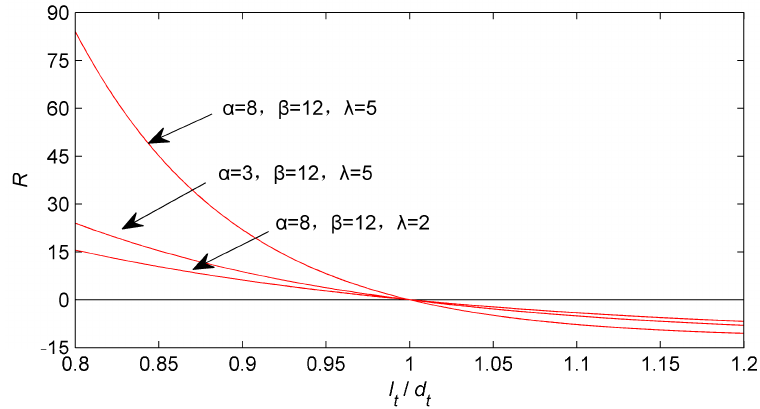
Figure 2. User dissatisfaction function with different parameters.